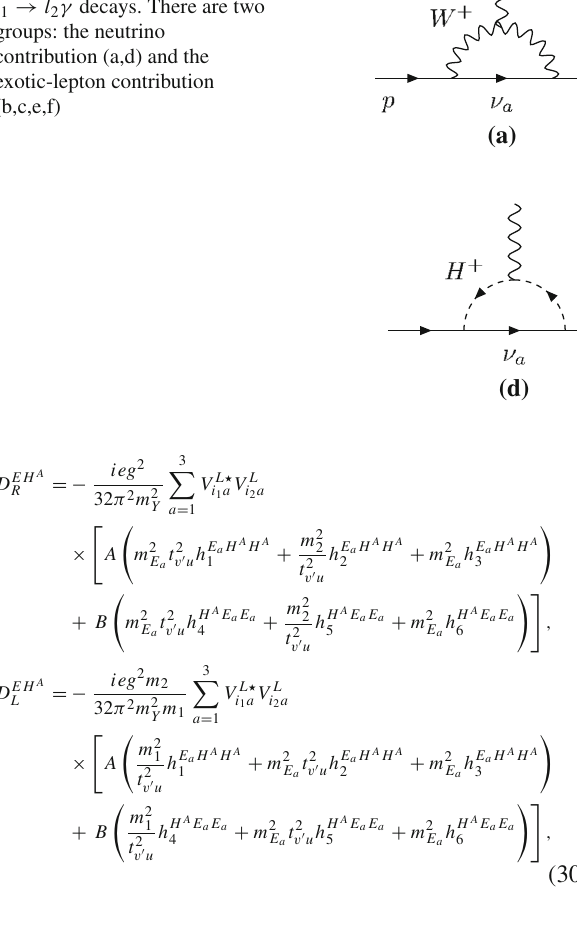
Fig. 1 Representative Feynman diagrams contributing to l 1 → l 2 γ decays. There are two groups: the neutrino contribution (a,d) and the exotic-lepton contribution